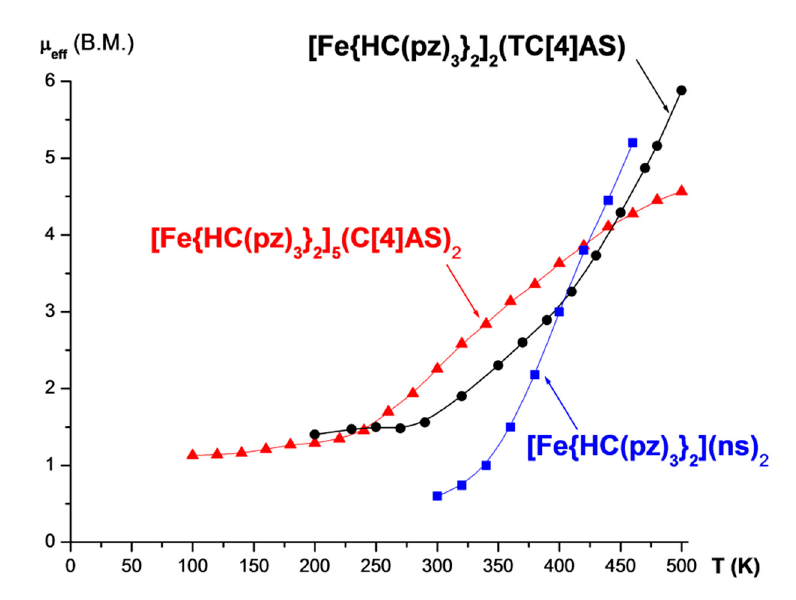
Figure 11. The μ eff (T) plots for [Fe(HC(pz) 3 ) 2 ] 5 (C[4]AS) 2 , [Fe(HC(pz) 3 ) 2 ] 2 (TC[4]AS), and their comparison with [Fe(HC(pz) 3 ) 2 ](ns) 2 (where ns = 2-naphthalenesulfonate C 10 H 7 SO 3 − ).